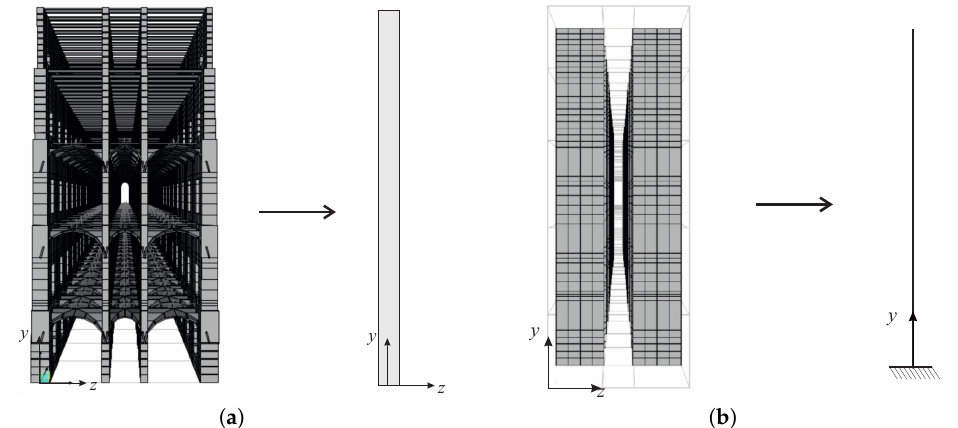
Figure 5. Homogenization scheme in the plane y − z of: ( a ) the LW model; ( b ) a couple of localized transverse